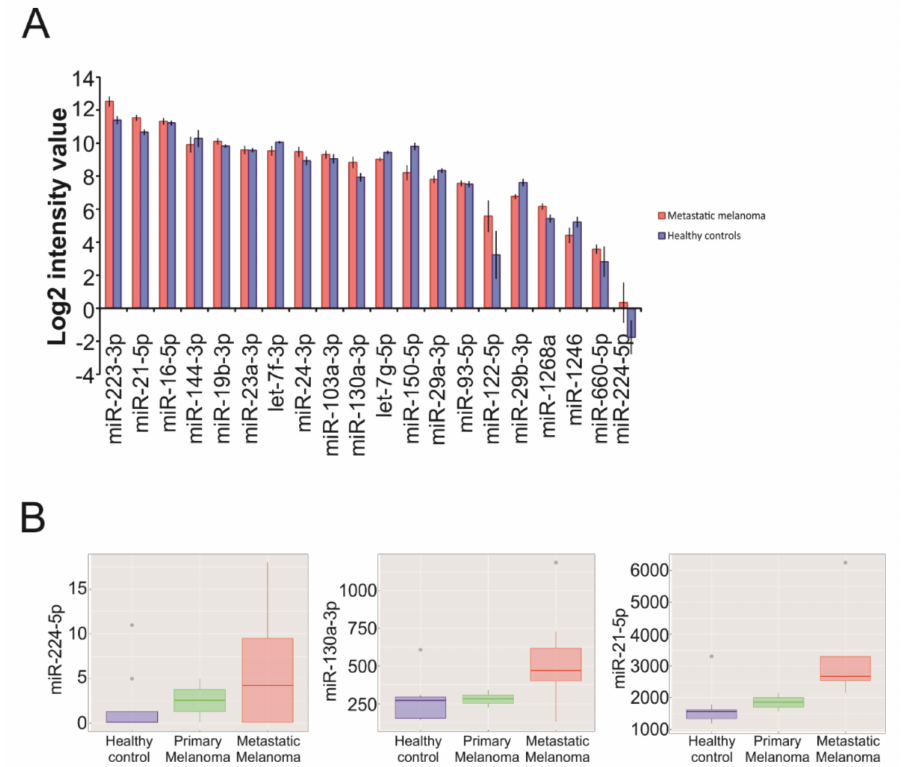
Figure 7. miRNAs expressed in EVs of metastatic melanoma patients included in a public dataset of melanoma clinical cases. ( A ) For the 20 validated miRNAs, normalized expression levels are reported for Stage IV metastatic melanoma group ( n = 8, red) and healthy controls ( n = 8, blue) included in the dataset. Values are expressed as mean of the log2 quantile-normalized probe intensity values obtained from GEO Series GSE100508 ± standard error. ( B ) Three EV-associated miRNAs showing a trend of upregulation during melanoma progression from healthy control to primary and metastatic tumors. Boxplots show normalized probe intensity values for each miRNA in healthy controls ( n = 8, blue), primary ( n = 2, green) and metastatic ( n = 8, red) melanoma patients obtained from GEO Series